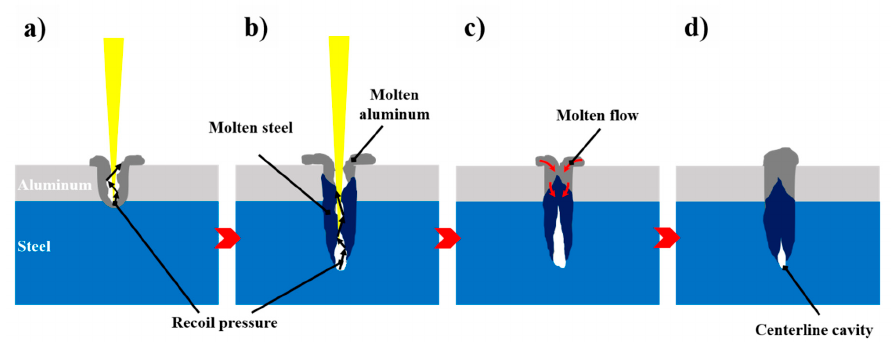
Figure 8. Illustration of the formation of “upward penetration (UP)”: ( a ) melting process of the upper material, ( b ) melting process of the lower material, ( c ) downward flow of the molten material, ( d ) the cross-section after solidification.